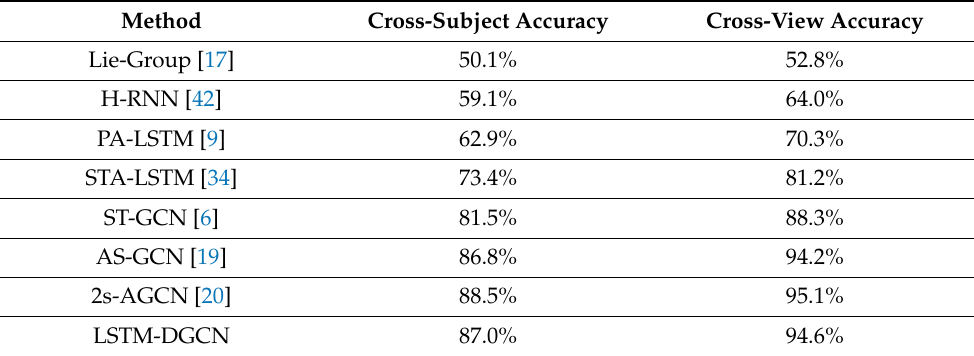
Table 5. Comparison of action recognition performance on NTU-RGB+D. The classification accuracies on both cross-subject and cross-view benchmarks are